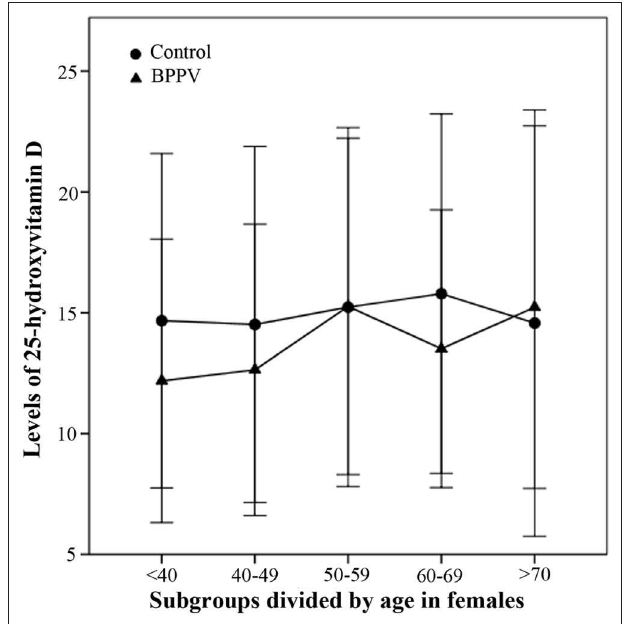
FIGURE 4 | Comparison of female 25-hydroxyvitamin D levels between BPPV and control subgroups divided by age. The median levels of female 25(OH)D in subgroups divided by age are indicated by black circles in control group and by black triangles in BPPV group. Error bars show standard